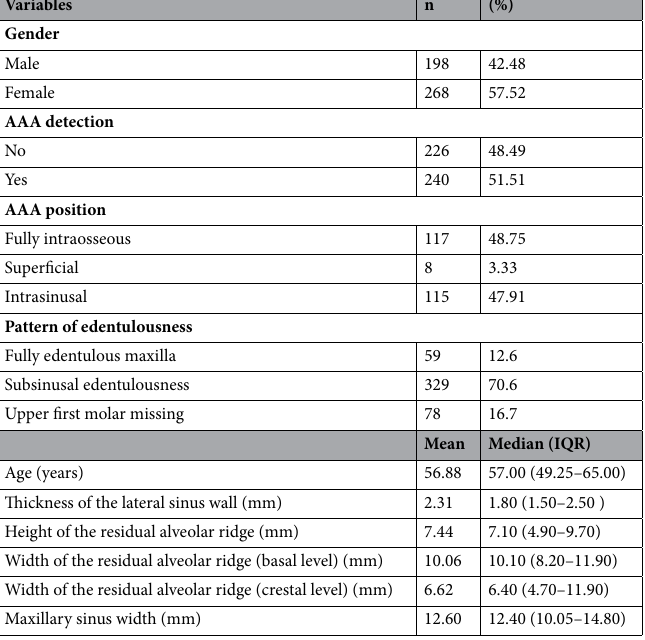
Table 1. Main features of the sample